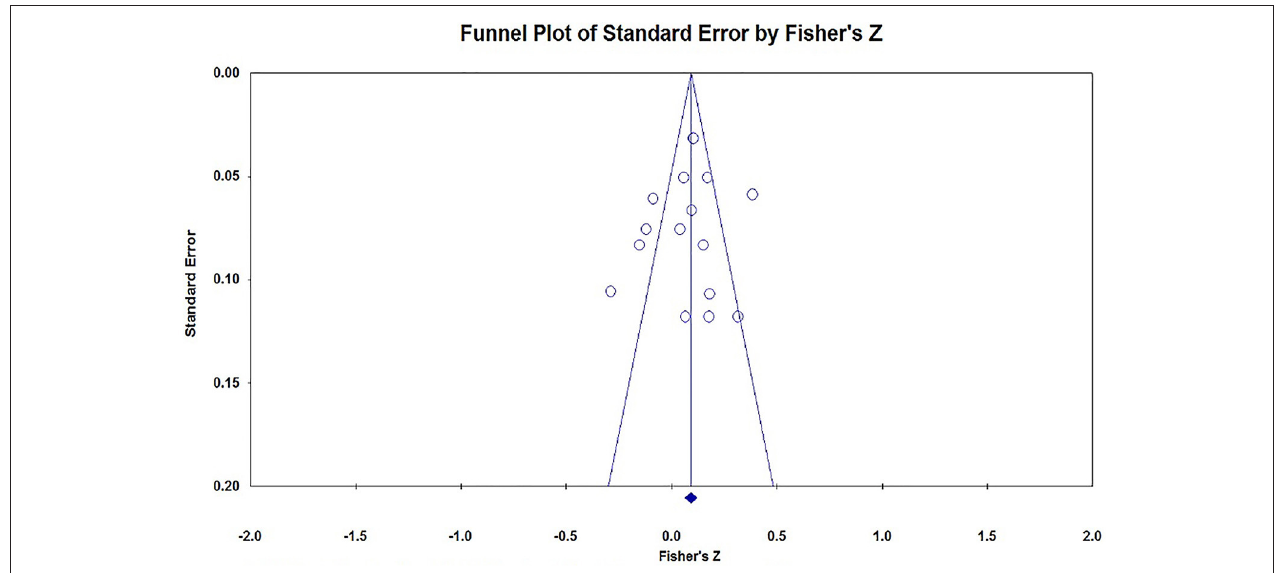
FIGURE 4 | Funnel plot of the effect size feminine preference ( x =